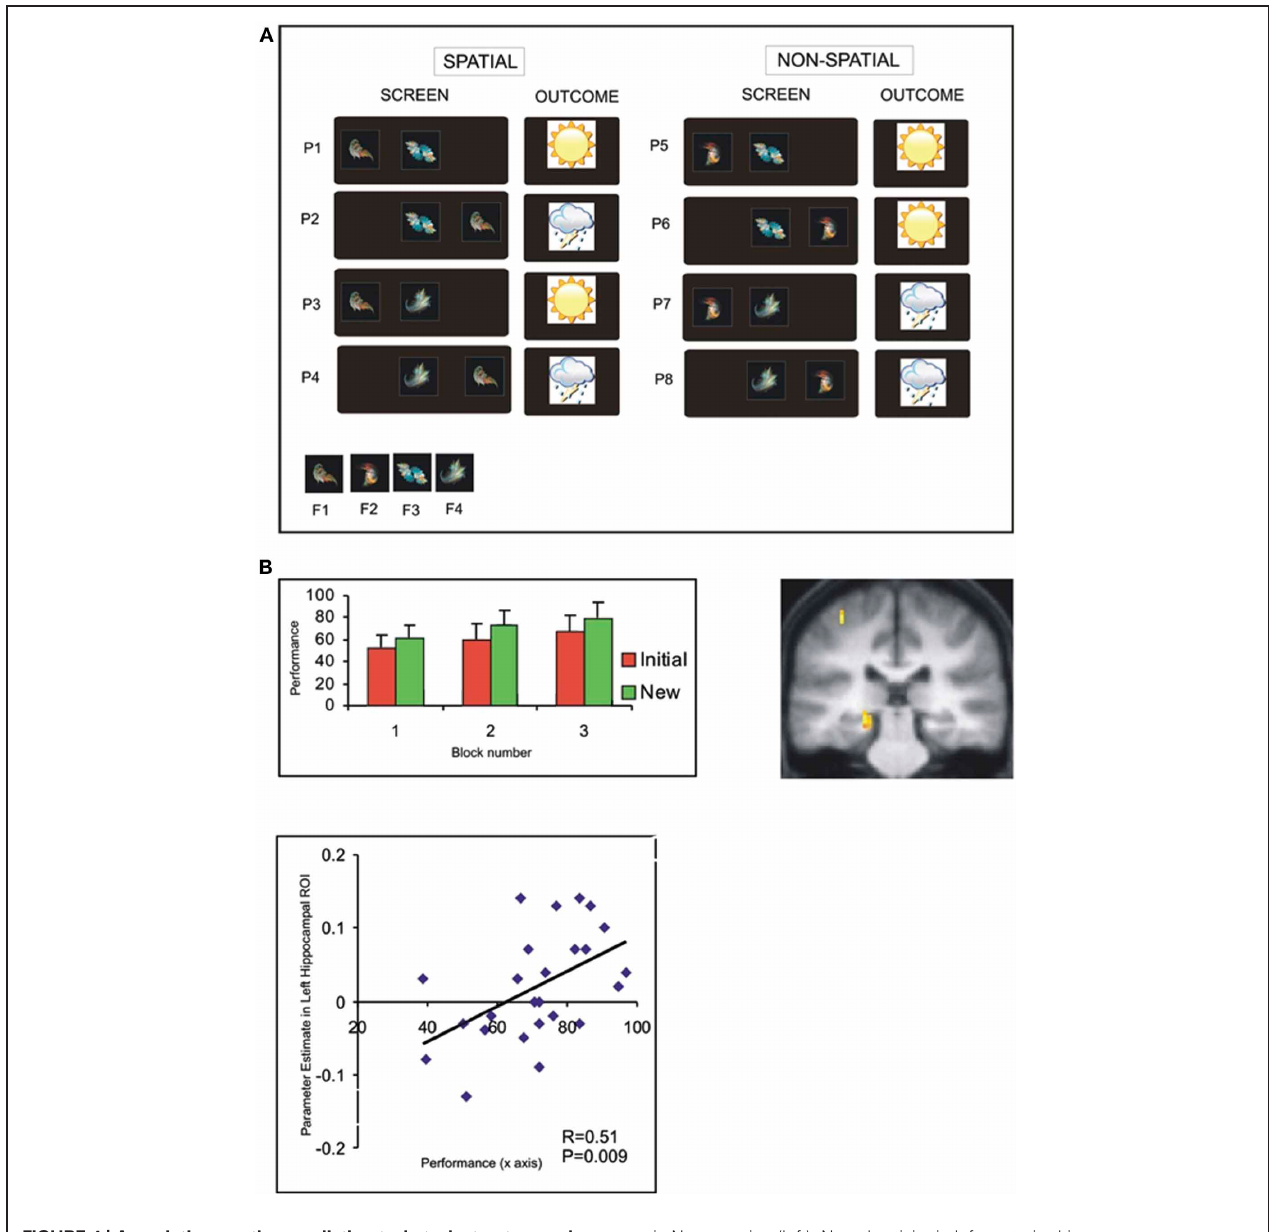
FIGURE 4 | Associative weather prediction task: task structure and evidence that neural activity in hippocampus correlates with transfer ability (Kumaran et al., 2009). (A) Depiction of eight patterns presented during training: the terms “spatial” and “non-spatial” refer to the type of information which determines the outcome (i.e., shape-location, or shape-shape, respectively). (B) Behavioral evidence of superior performance